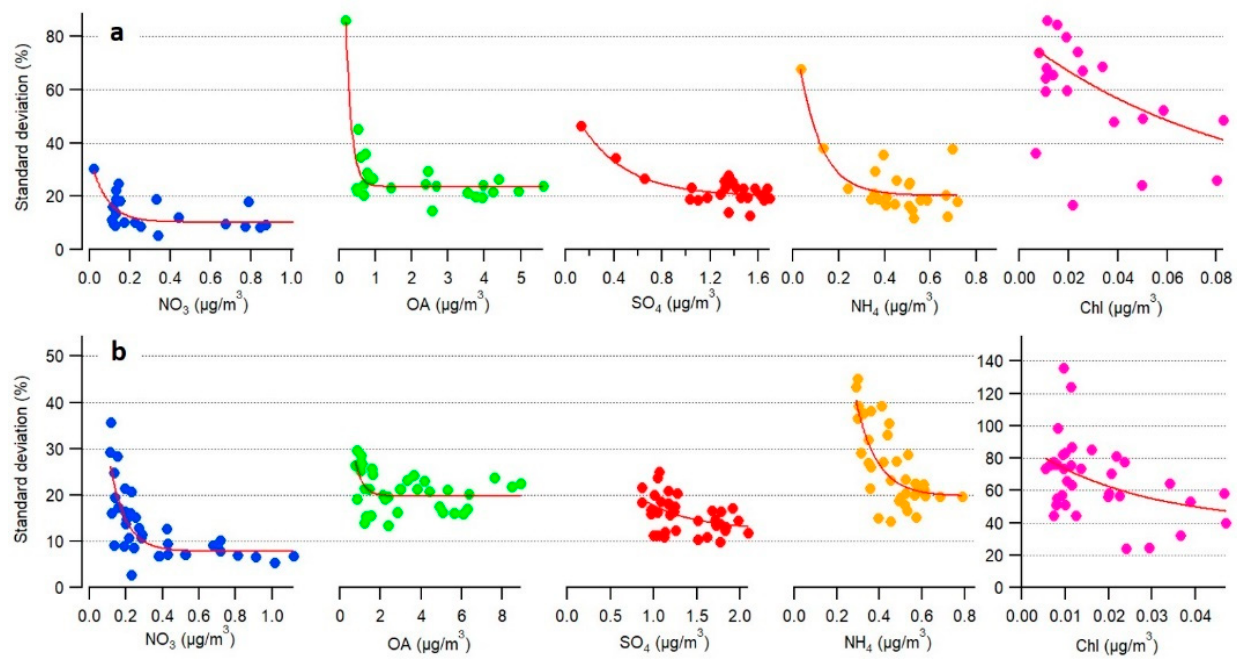
Figure 4. Standard deviations of 8 co-located ACSM measurements before ( a ) et after ( b ) response factor (RF) and relative ionization efficiency (RIE) calibrations during the 2019 ILC campaign.